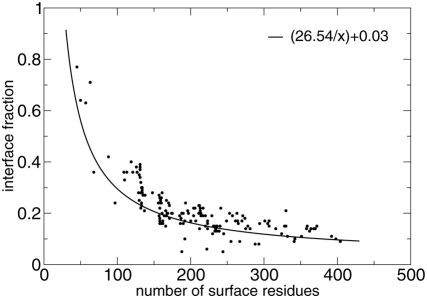
Protein surface size and interface fraction.Plot of the  function relating surface size and fraction of the
surface covered by the interface. Dots correspond to JET predictions on
all proteins in the Huang dataset, where predicted interface sites are
computed with mixed trace values.